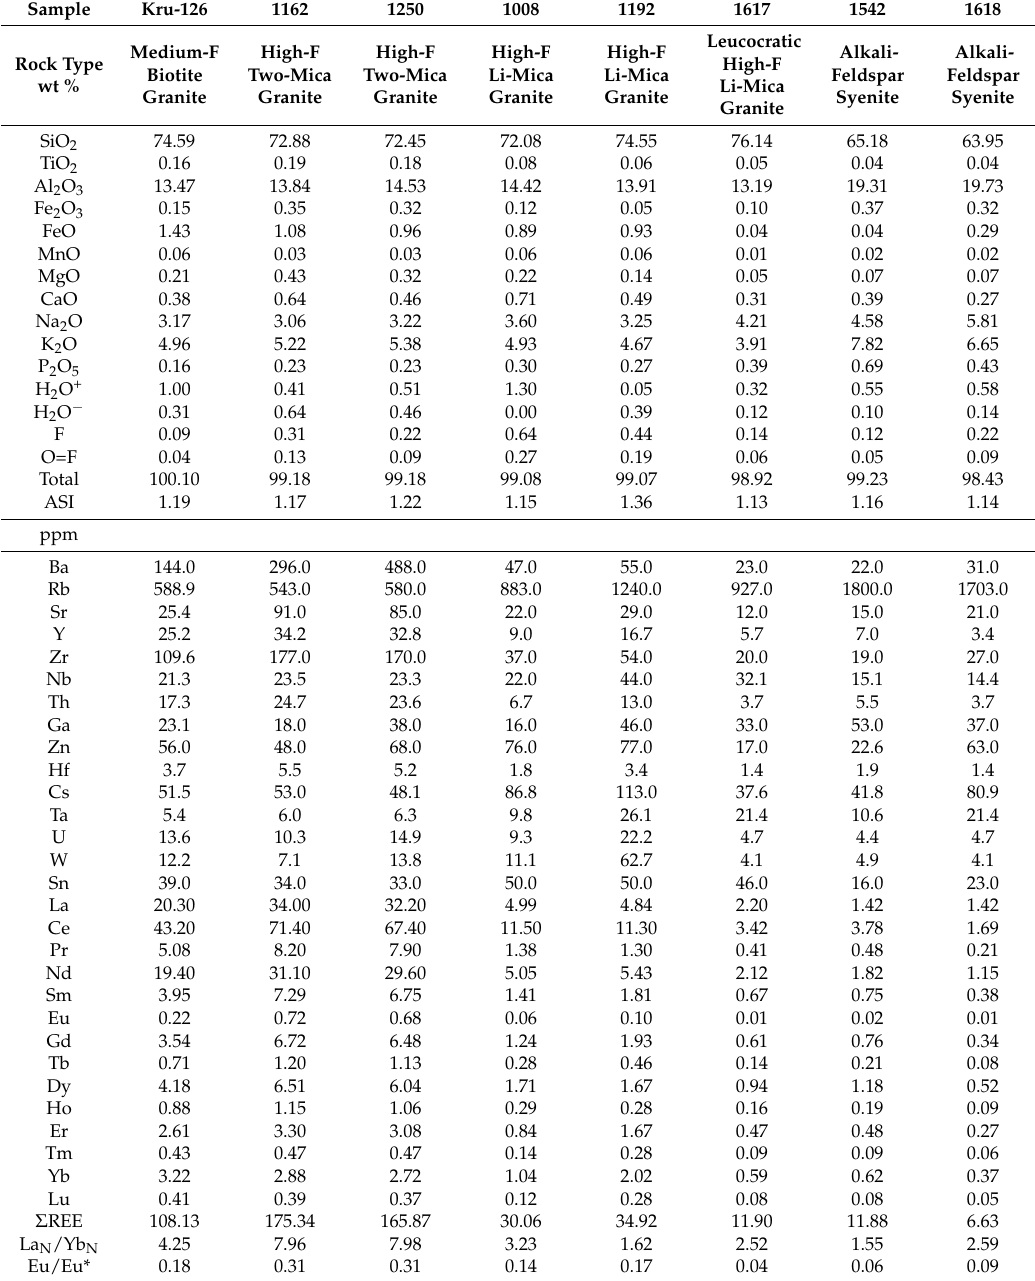
Table 1. Whole-rock chemical analyses of granitic rocks of the Krudum granite